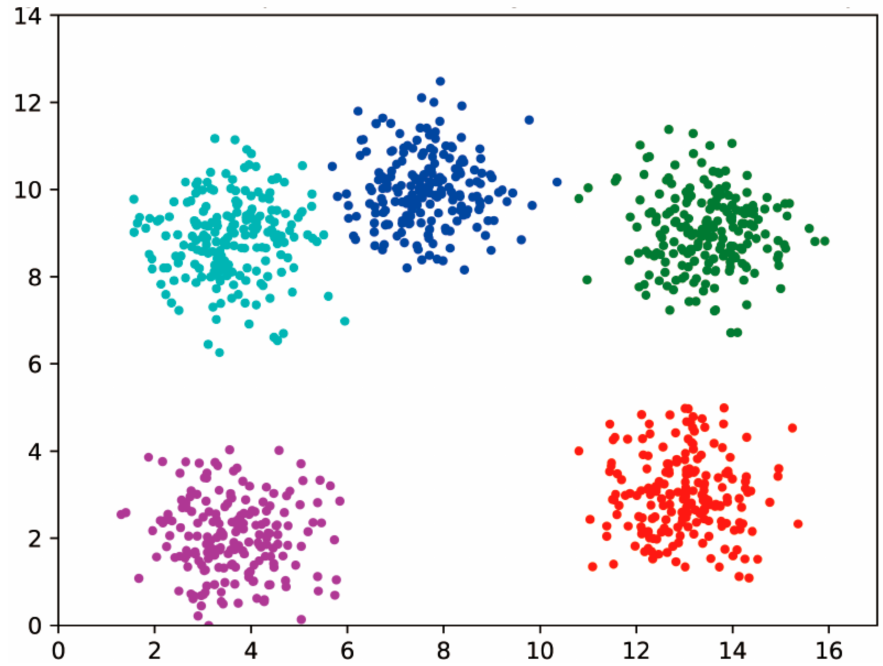
Figure 10. Dataset A Ciphertext clustering results with 4 decimal